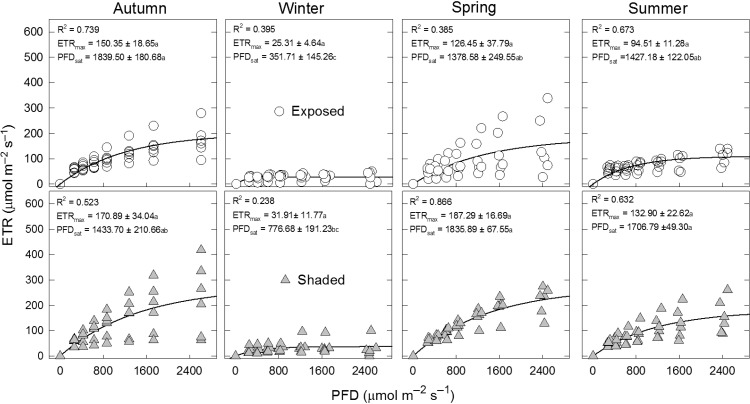
Rapid light curves determined from the maximum apparent electron transport rate (ETRmax) and the saturating photosynthetically active photon flux density for PSII (PFD), by adjusting an exponential function using the Sigma Plot Program. Data are means ± SE, n = 6. For PFDsat, different letters represent significant differences between the interaction micro-environment × season (P < 0.05). For ETRmax, this interaction was not significantly affected (P > 0.05).